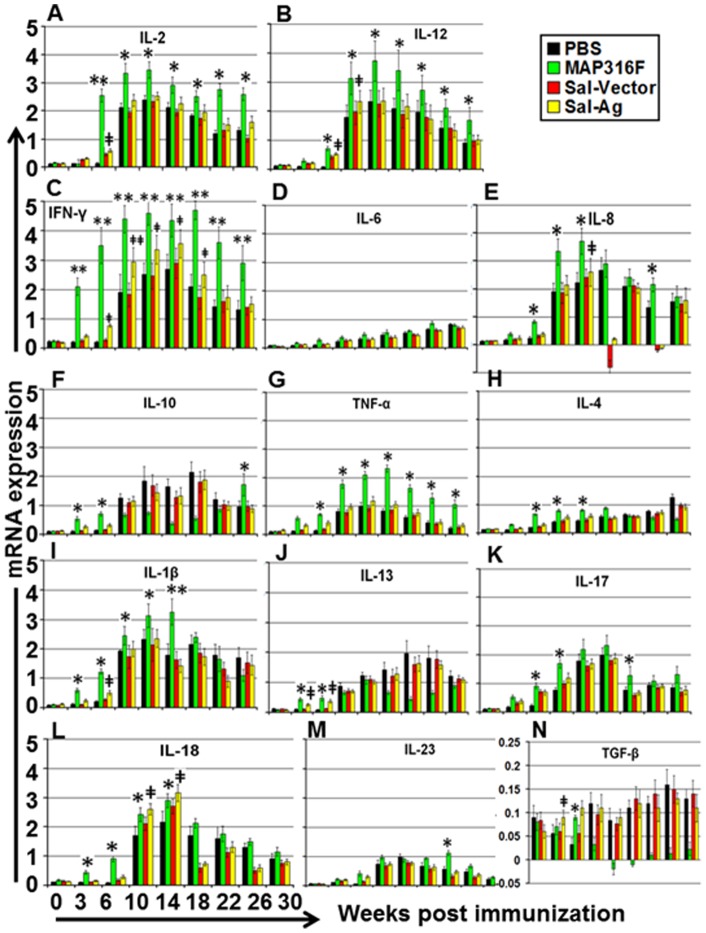
Cytokine analysis by RT-PCR.Relative transcription of Th1, Th2, pro-inflammatory, anti-inflammatory, Th17 and regulatory cytokines in PBMCs isolated from animals bled at various time points after immunization and stimulated with/without Ag-mix (15 μg/ml) or PPDj (10 µg/ml) for 3 days was measured by RT-PCR. The relative transcription was calculated using the value of unstimulated cells as the calibrator with the housekeeping gene GAPDH as an internal control. Data are presented as the relative mRNA expression (mean fold change) and the mean value of each group. The error bars indicate standard deviation from the mean. (PBS Vs 316F *indicates p<0.05 ** indicates p<0.01, PBS Vs Sal-Ag ‡ indicates p<0.05 ‡‡ indicates p<0.01).